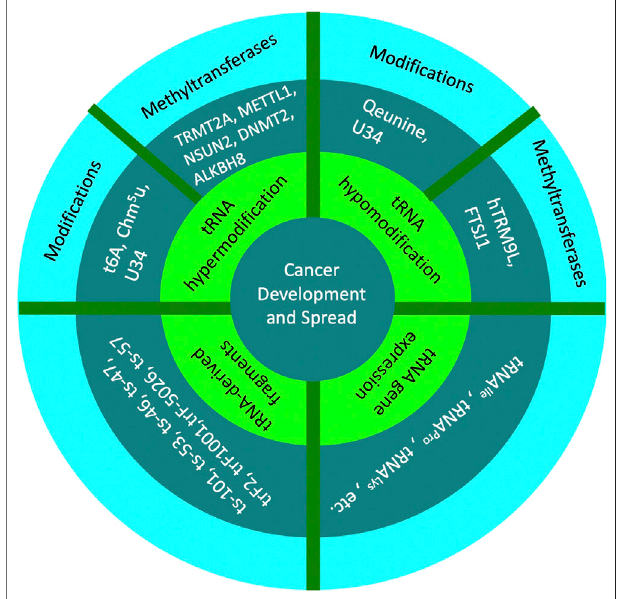
FIGURE 2 | This diagram lists examples of tRNA hypermodi fi cation, tRNA hypomodi fi cation, tRNA gene expression, and tRNA-derived fragments that canleadtocancerdevelopmentand spread. FortRNA hypermodi fi cation and tRNA hypomodi fi cation, the diagram includes tRNA modi fi cations and tRNA methyltransferases associated with cancer development and